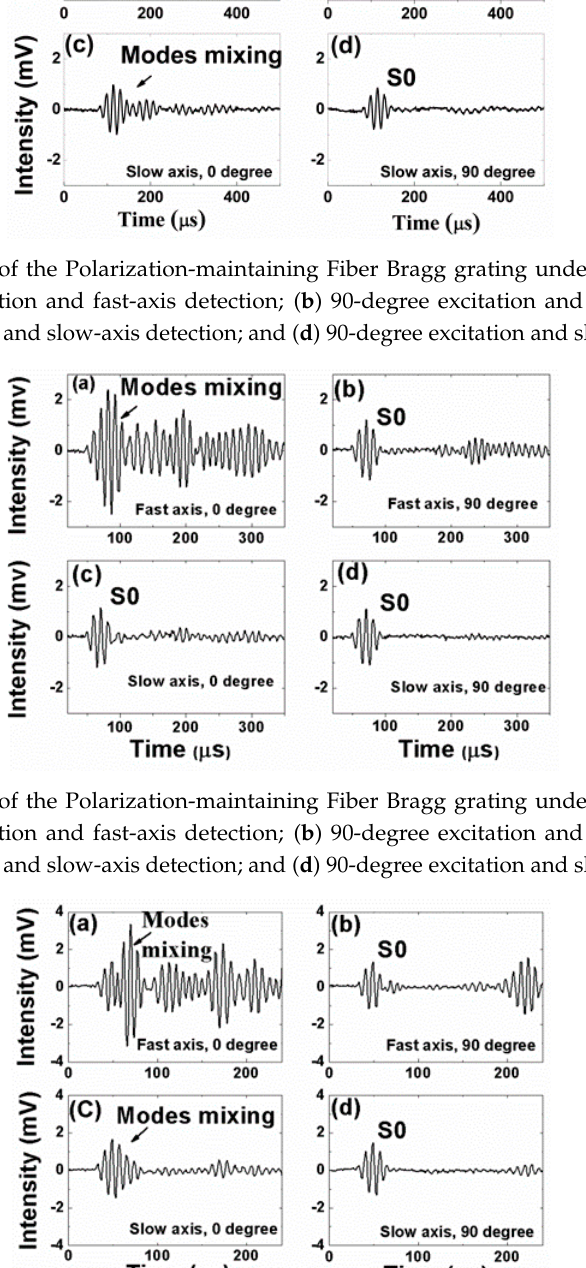
Figure 8. Responses of the Polarization-maintaining Fiber Bragg grating under 120 kHz actuation to ( a ) 0-degree excitation and fast-axis detection; ( b ) 90-degree excitation and fast-axis detection; ( c ) 0-degree excitation and slow-axis detection; and ( d ) 90-degree excitation and slow-axis